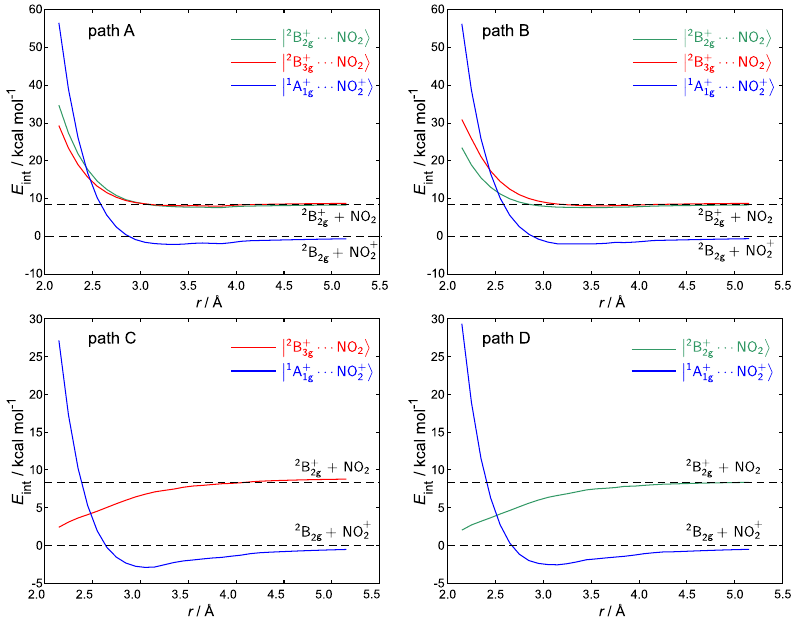
Figure 4. Predicted interaction energy of benzene/benzene + with NO + /NO 2 in dichloromethane as 2 a function of the distance of the interacting units, oriented as in the paths A, B, C, and D of Figure 1. (cid:12) (cid:11) + Independently of the explored path, the polar state remains stable up (cid:12) 1 A 1g · · · NO 2 to ca. 2.5 Å. At shorter distances, the SET is predicted to also occur in solution. Indeed, for both paths A/B, which do not give rise to stable π complexes, and C/D giving rise to (cid:12) (cid:11) stable complexes, the curves corresponding to the states systematically (cid:12) ArH + · · · NO 2 (cid:12) (cid:11) + fall below the one of the states (see also Tables S8–S11 in the Supplemen- (cid:12) ArH · · · NO 2 tary Materials).